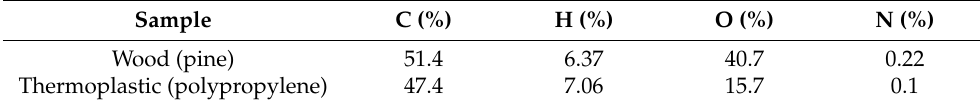
Table 1. Ultimate analysis of wood and thermoplastic